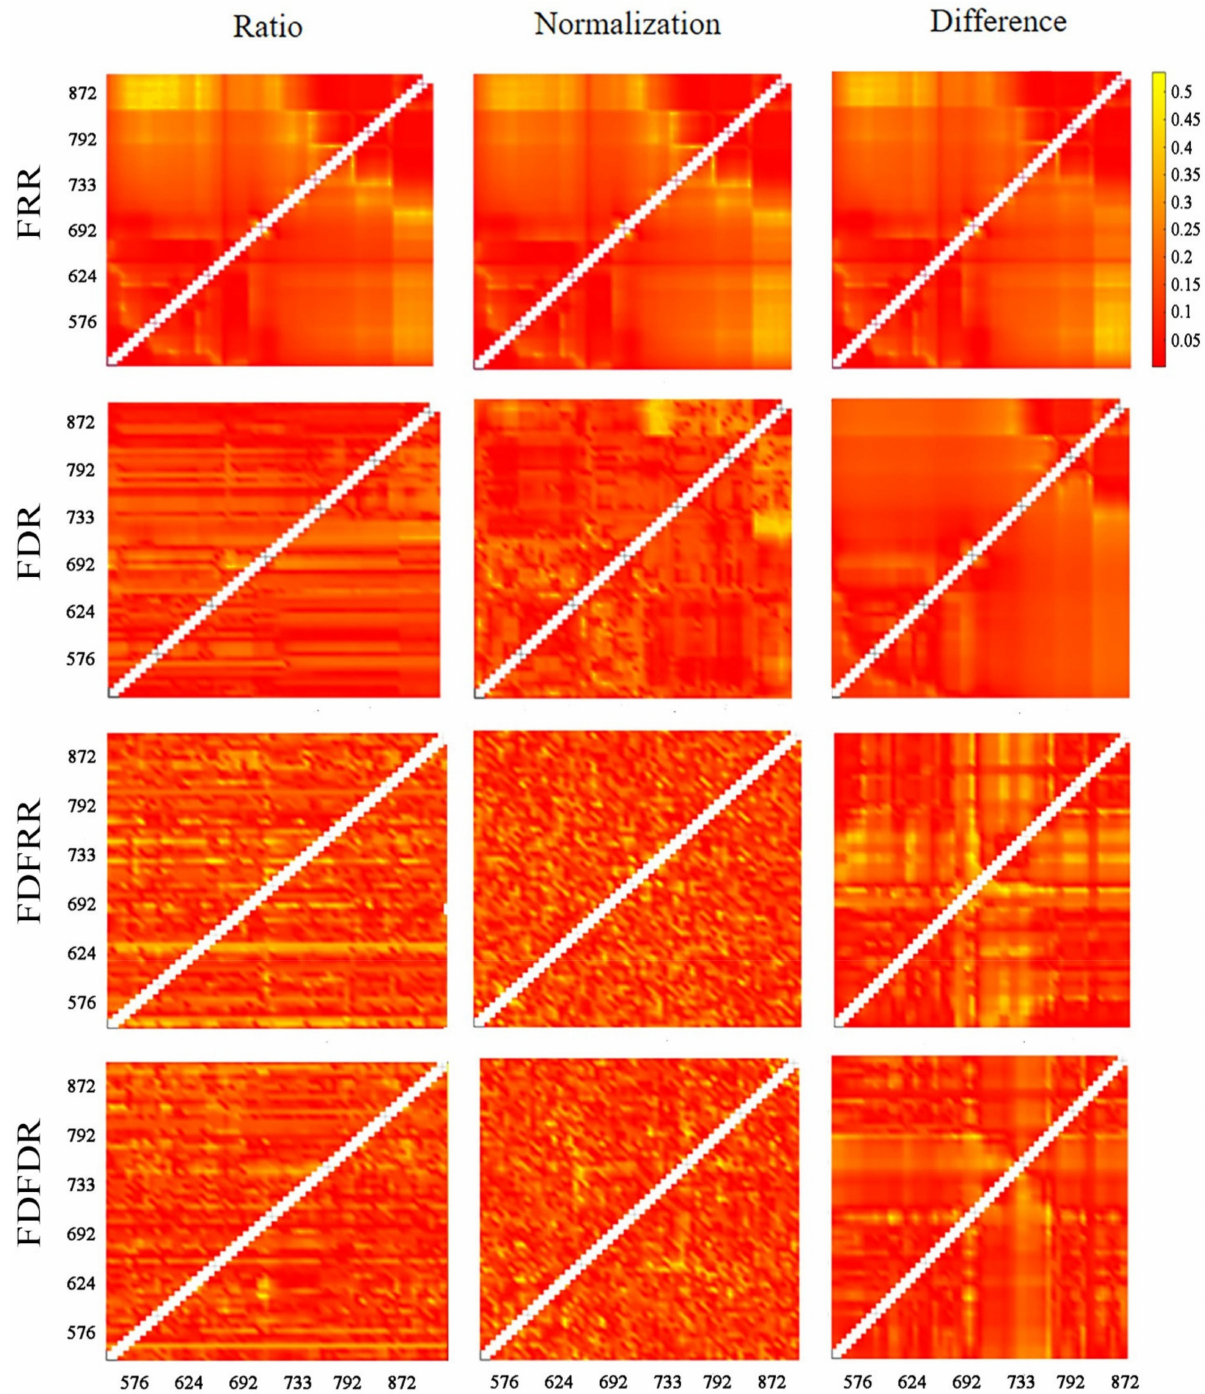
Figure 6. Correlation analysis of sensitive bands in the florescence ratio reflectance (FRR), the florescence differ- ence reflectance (FDR), the first derivative florescence ratio reflectance (FDFRR) and the first derivative difference re- flectance